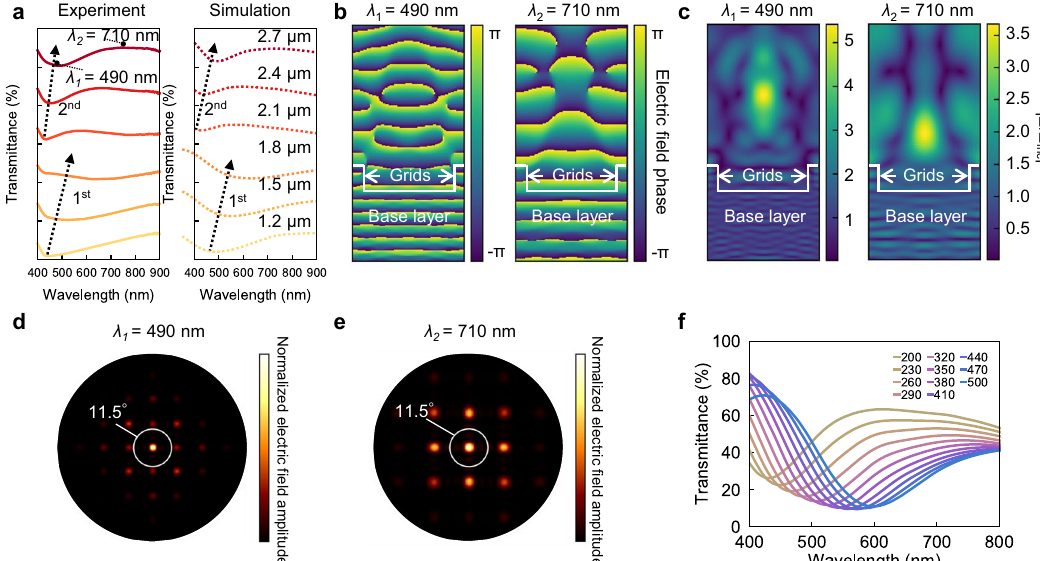
Fig. 3 Finite difference time domain (FDTD) analysis of the grid structure. a Measured and FDTD simulated transmittance spectra of structures with different nominal height h 2 (from the black dashed rectangle in Fig. 2a ranging from 1.2 μ m to 2.7 μ m. 1st and 2nd represent the fi rst and second order resonance dip respectively). Marked positions λ 1 = 490 nm and λ 2 = 710 nm are used for FDTD fi eld analysis in Fig. 3 b – e . b , c Cross section view of near- fi eld normalised electric fi eld phase and amplitude for a grid structure (laser power: 30 mW, write speed: 1 mm/s, nominal grid height: h transmittance 490 nm and peak transmittance 710 nm wavelength respectively (| E / E inc | represents the normalised electric fi eld amplitude). d , e Top view of far- fi eld normalised electric fi eld amplitude for the above grid structure at dip transmittance 490 nm and peak transmittance 710 nm wavelength respectively; the white circle represents collection fi eld for the microscope used in this work (NA = 0.2, CA = 11.5°). f Simulated transmittance spectra for structures with different linewidth w 1 (the colours of the spectrum lines were mapped from the corresponding